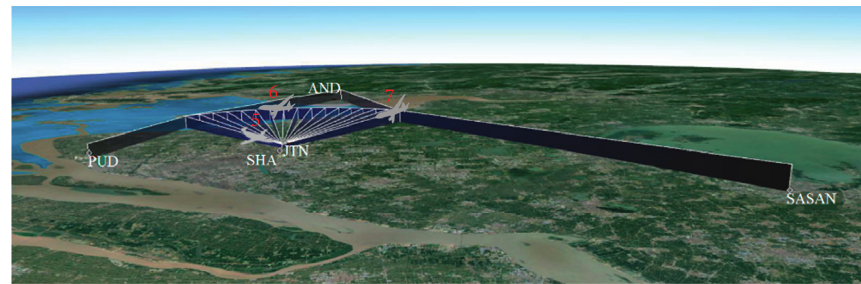
Figure 18: Change of aircraft landing sequence. Table 4: Sequencing results of aircraft under different